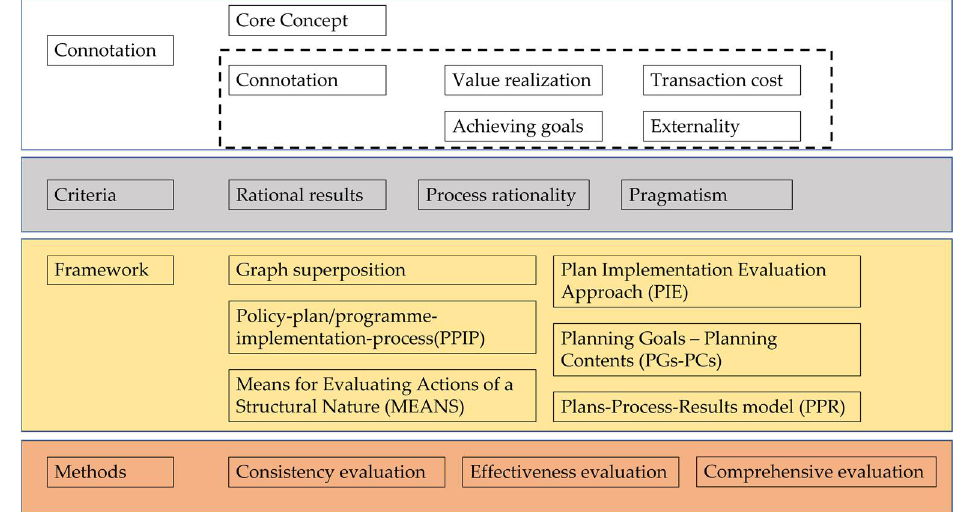
Figure 1. Literature Review Framework.